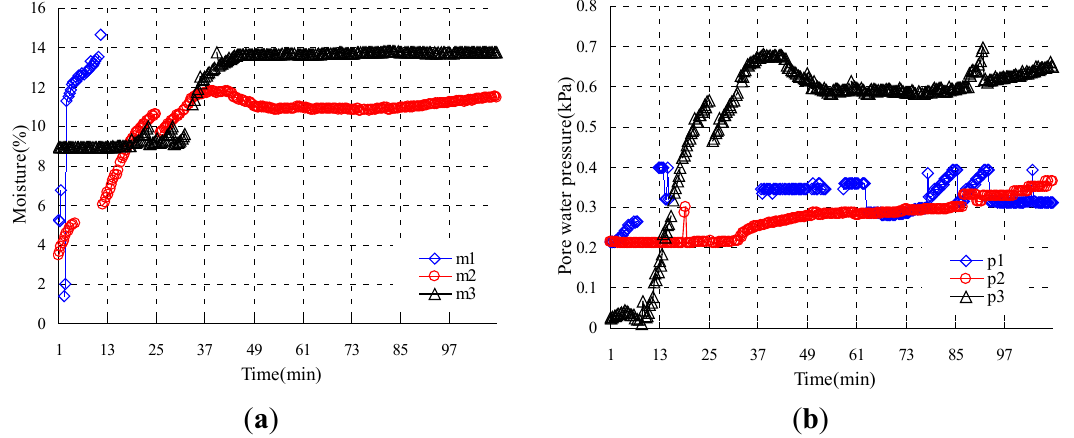
Figure 8. Soil Sample 1-45 mm/h: ( a ) Moisture content of m1, m2, and m3; and ( b ) pore water pressure of p1, p2, and p3.